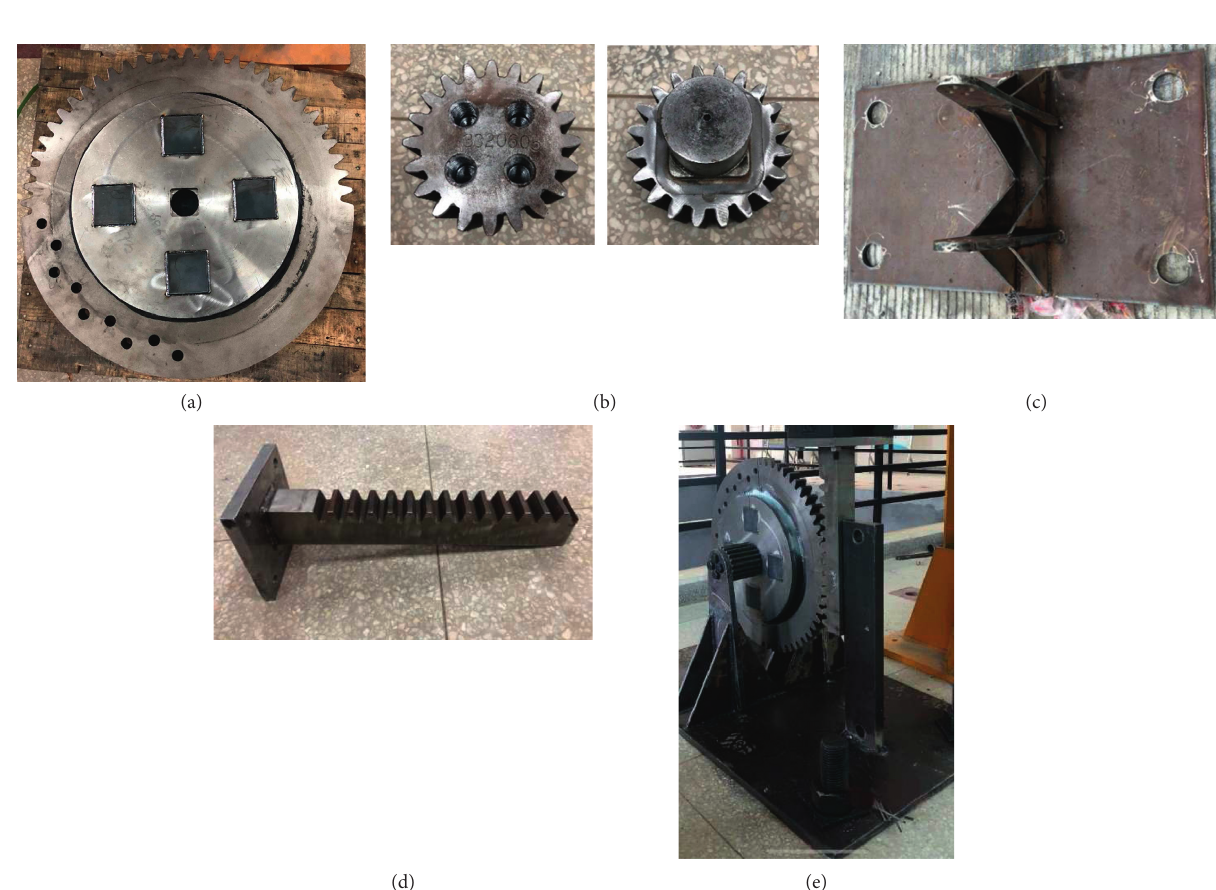
Figure 6: Physical model of the DATD. (a) Damper body (before installation). (b) Gear cylinder. (c) Base. (d) Straight teeth. (e) DATD on the